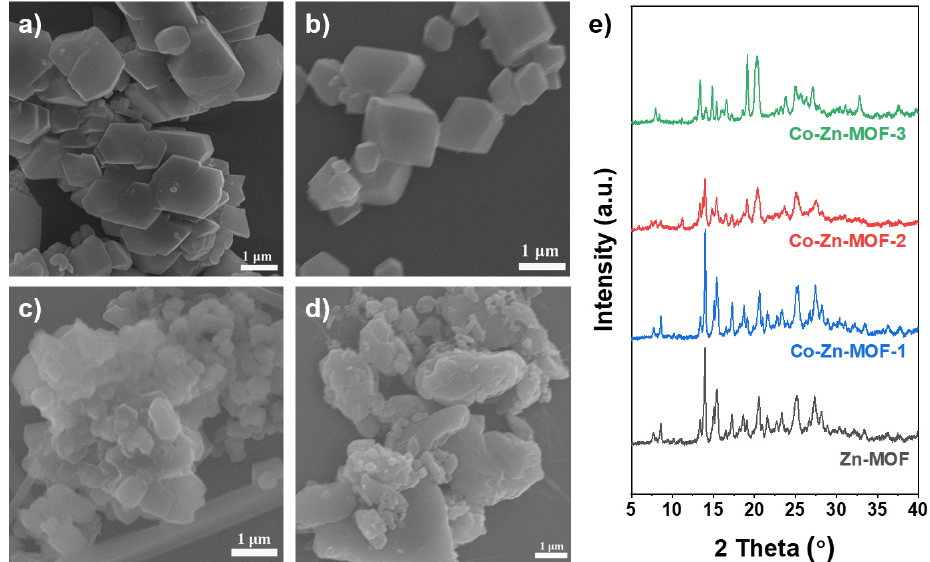
Figure 1. SEM images of ( a ) Zn-MOF, ( b ) Co-Zn-MOF-1, ( c ) Co-Zn-MOF-2, and ( d ) Co-Zn-MOF-3; ( e ) XRD patterns of the Zn-MOF and Co-Zn-MOF precursors.